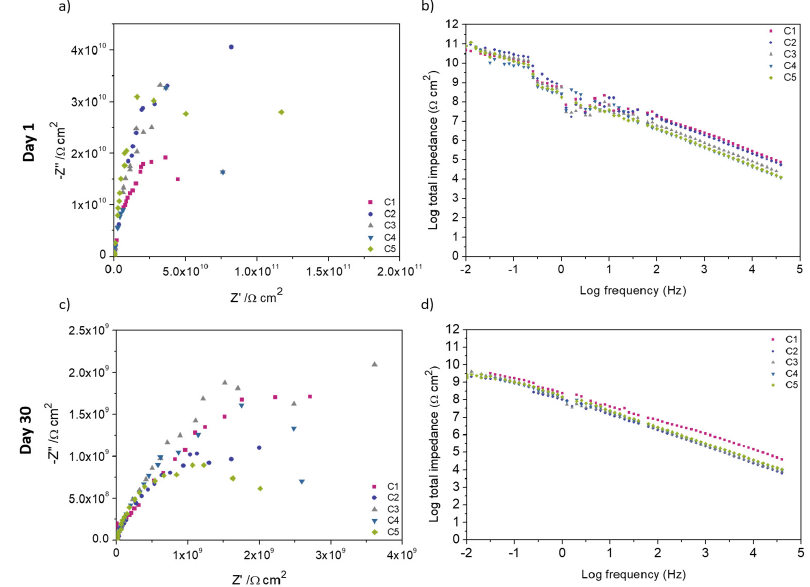
Figure 8. EIS data for the first day and day 30; ( a ) Nyquist and ( b ) Bode plot for the samples on the first day of measurement. The data is scattered and roughly forms semicircle. ( c ) Nyquist and ( d ) Bode plot on day 30 of measurement shows data is more defined and smoother.